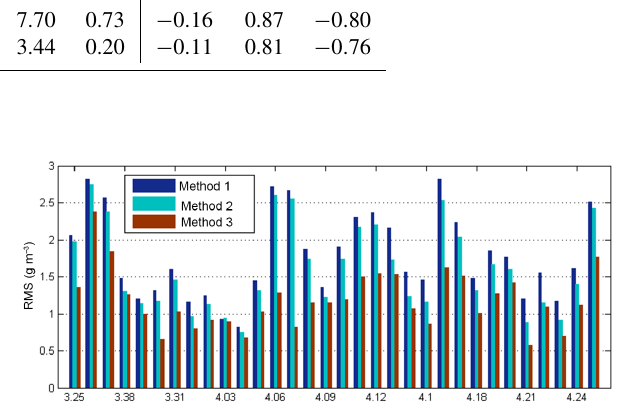
Figure 8. Comparison of IWV time series derived from radiosonde and different tomographic methods in the experiment.